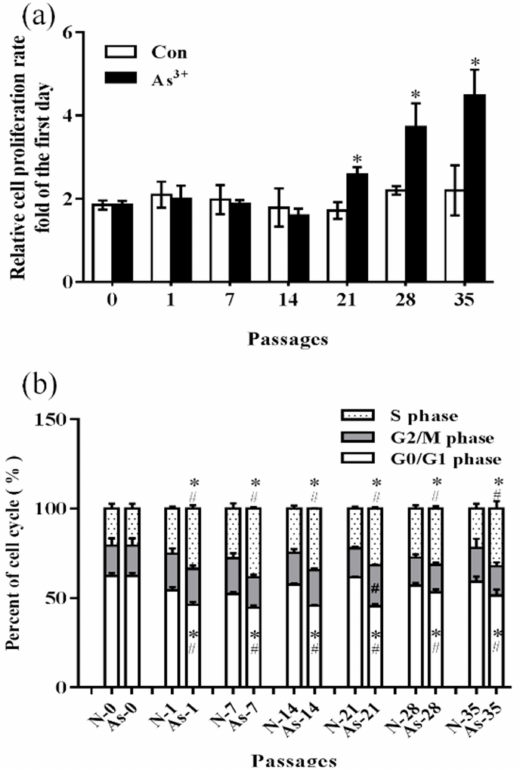
Figure 1. Changes in cell proliferation and cell cycle in HaCaT cells exposed to 1.0 µ M arsenite or without arsenite exposure for different passages. ( a ) Change in the cell proliferation rate in HaCaT cells. ( b ) Change in the cell cycle in HaCaT cells. Error bars are the mean ± SD ( n = 3). * Compared with the passage-matched control group, p < 0.05; # Compared with the experimental control group, p <